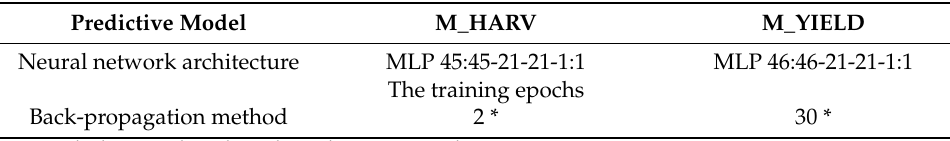
Table 2. A number of epochs and training methods for neural networks. Predictive